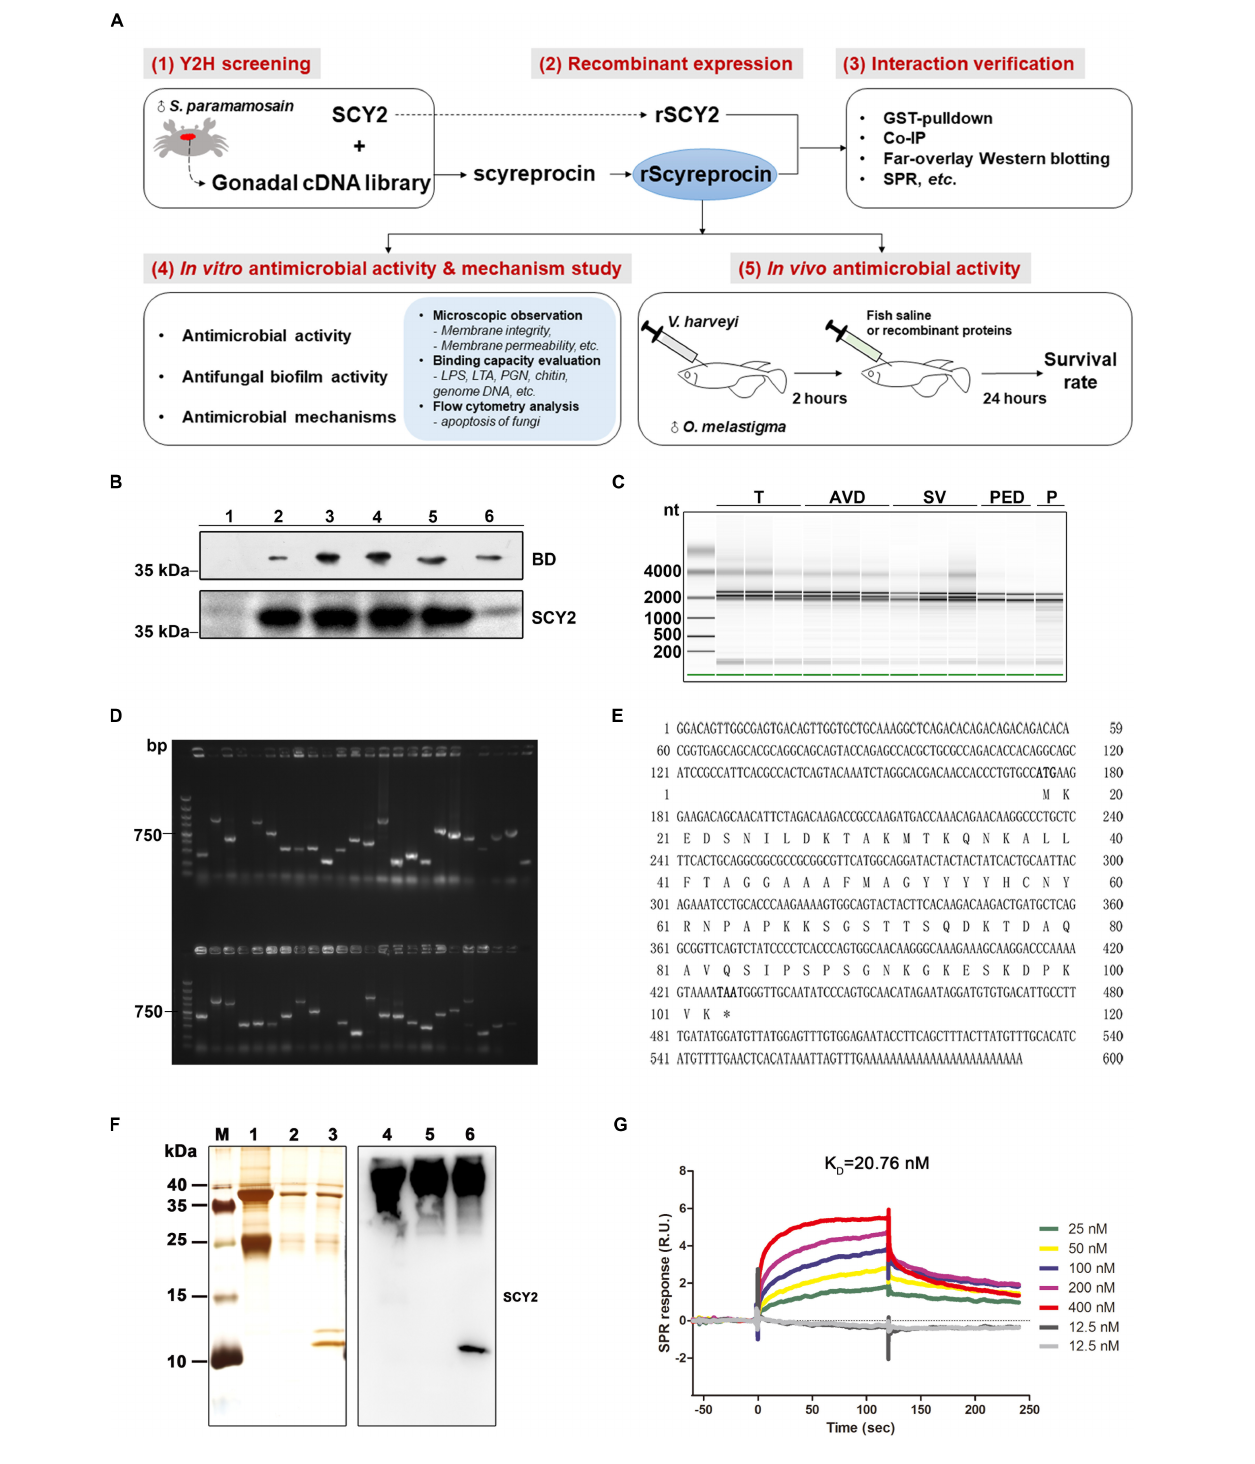
FIGURE 1 | Identification and verification of the SCY2-interacting protein. (A) Schematic diagram of the research route of rScyreprocin. (B) Expression of the fusion protein BD-SCY2 of the constructed bait strain was detected by Western blotting. (C) Total RNA extracted from different gonadal segments of sexually mature male S. paramamosain was examined for integrity by Agilent 2000. (D) Gel electrophoresis analyzation on diversity of the constructed cDNA library; DNA marker: DL2000. (E) Full-length cDNA and the deduced amino acid sequences of scyreprocin. (F) Co-immunoprecipitation analysis of the in vivo scyreprocin–SCY2 interaction in seminal plasma of sexually immature (lanes 2, 5) and mature (lanes 3, 6) crabs. Lanes 1 and 4, rabbit IgG controls. (G) Binding kinetic of rScyreprocin and rSCY2 assessed by surface plasmon resonance technology.